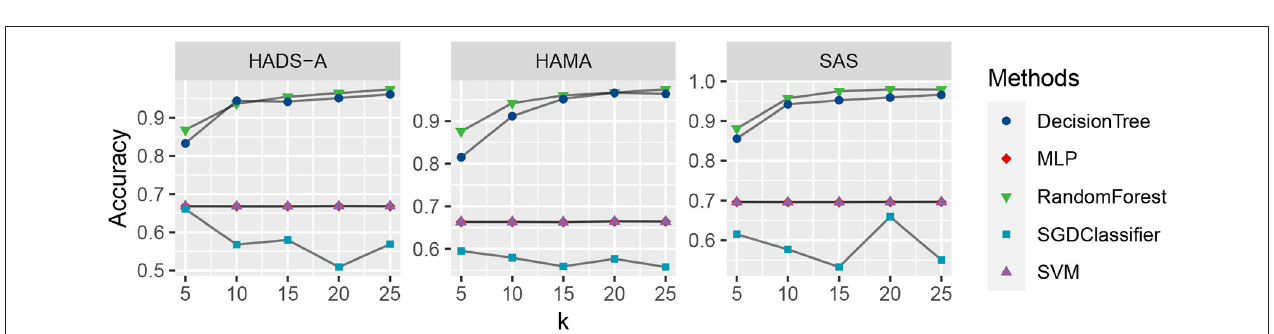
FIGURE 3 | Accuracy comparison of the five machine learning methods with varying k , evaluated by Hospital Anxiety and Depression Scale (HADS-A), Hamilton Anxiety Scale (HAMA), and SAS tests,